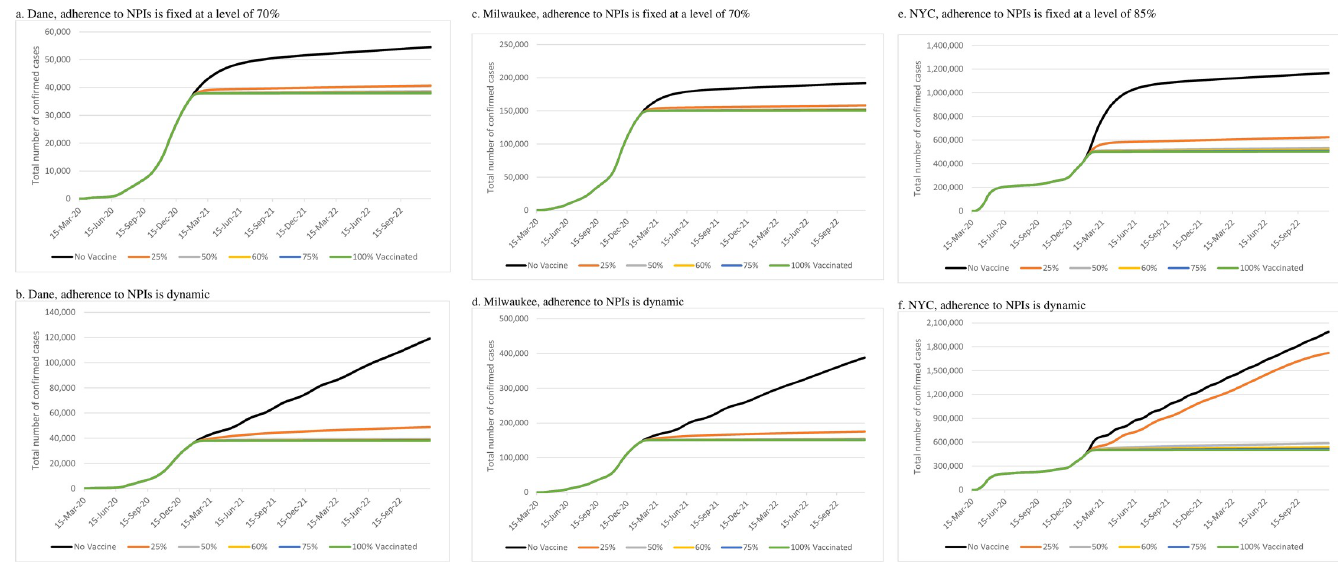
Fig 1. Impact of vaccine coverage on the number of confirmed cases in different regions for two different scenarios of adherence to nonpharmaceutical interventions (NPIs).